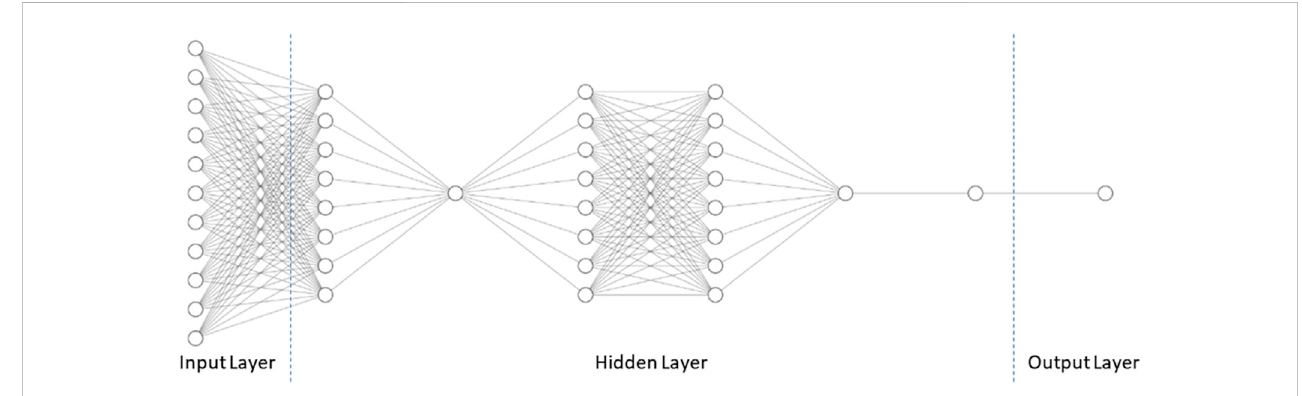
FIGURE 14 Neural network architecture for Stress prediction.